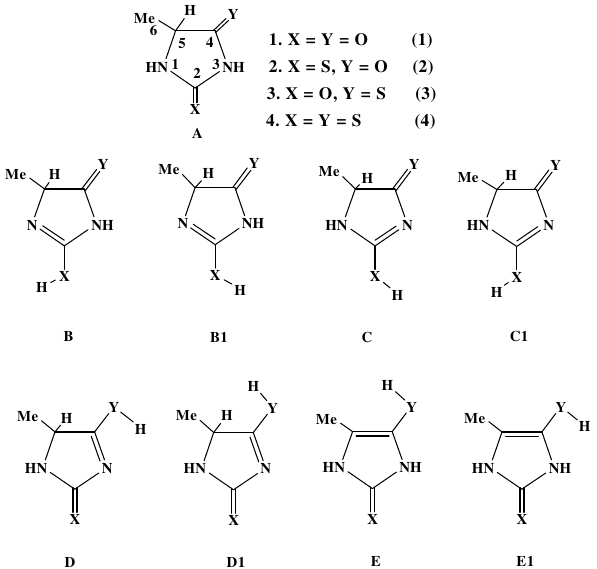
Figure 1. Different tautomeric forms of 5-methyl-2,4-oxo /